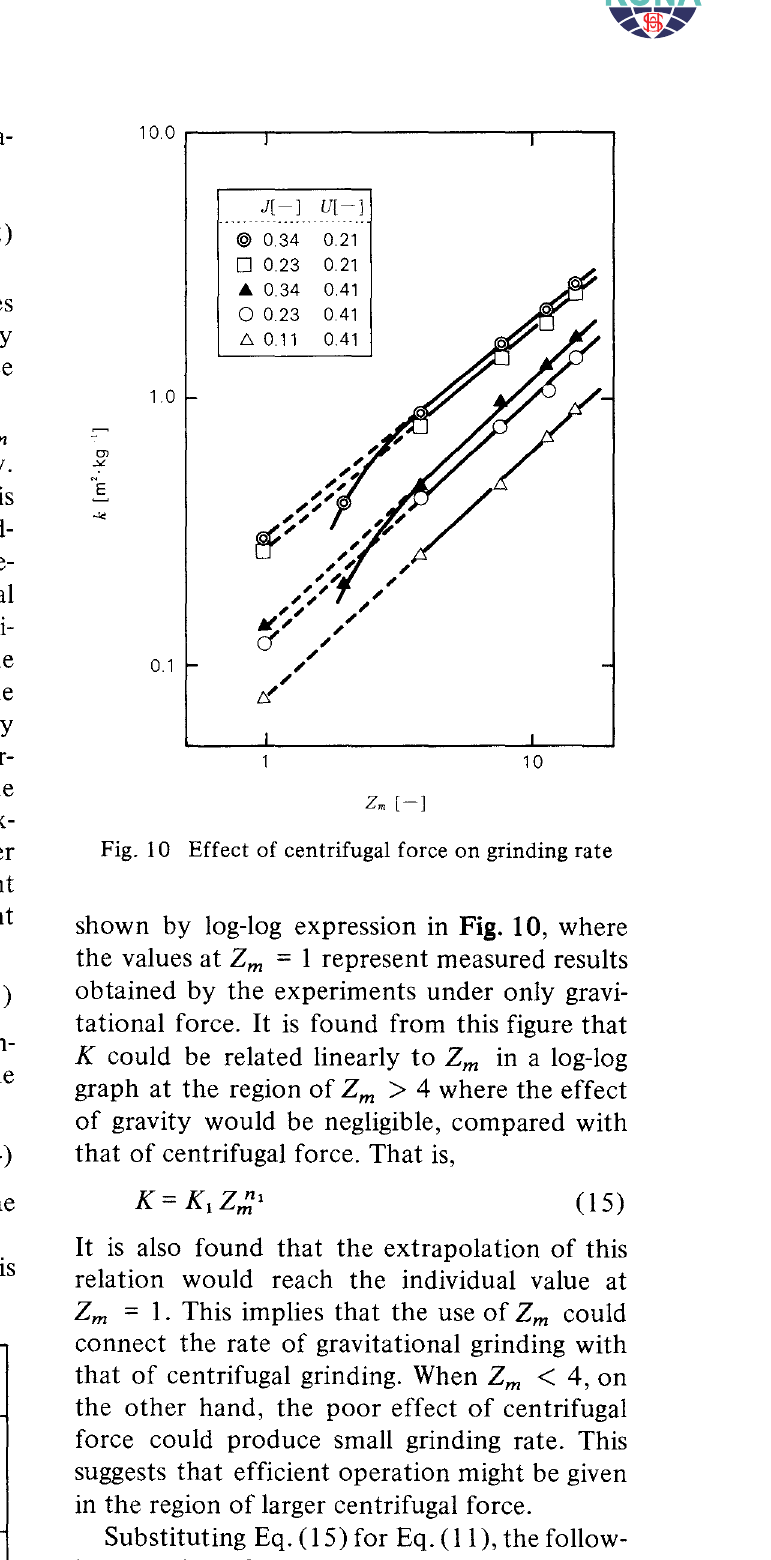
Fig. 9 Correlation of specific surface area of product with Zm · Nt